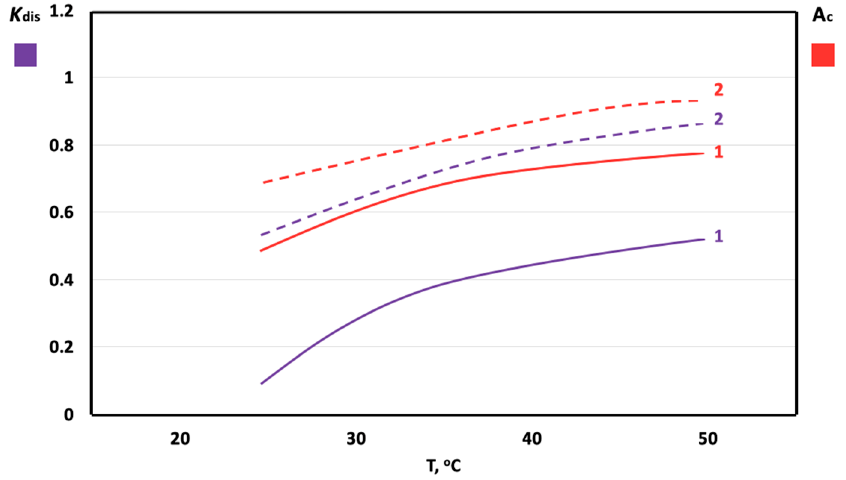
Figure 4. Affinity isotherms for HL-60-DNApol β /Poly(dT) 50 (1) and HL-60-DNApol β /Poly(dT) 200 (2)